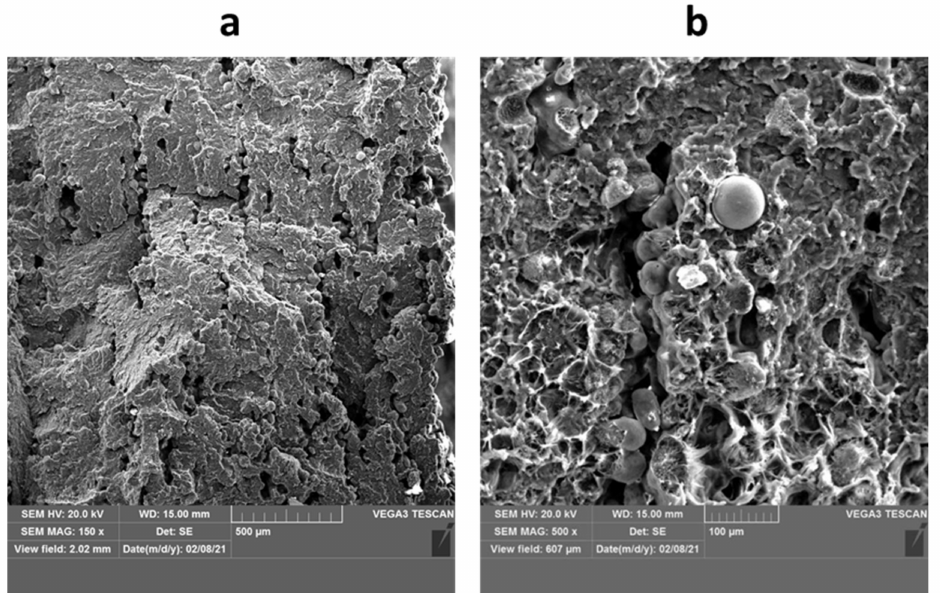
Figure 23. The interlayer porosity and unmelted tracks of powders observed for orientation 4, sample 4.3: ( a ) low magnification (150 × ) and ( b ) higher magnification (500 ×